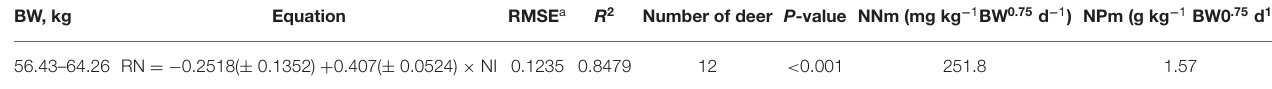
TABLE 7 | Estimates of retained N (RN, g kg − 1 BW0.75 d − 1) and N intake (NI, g kg − 1 BW 0.75 d − 1 ) in the equation to predict net protein requirement for maintenance (NPm, g kg − 1 BW 0.75 d − 1 ).